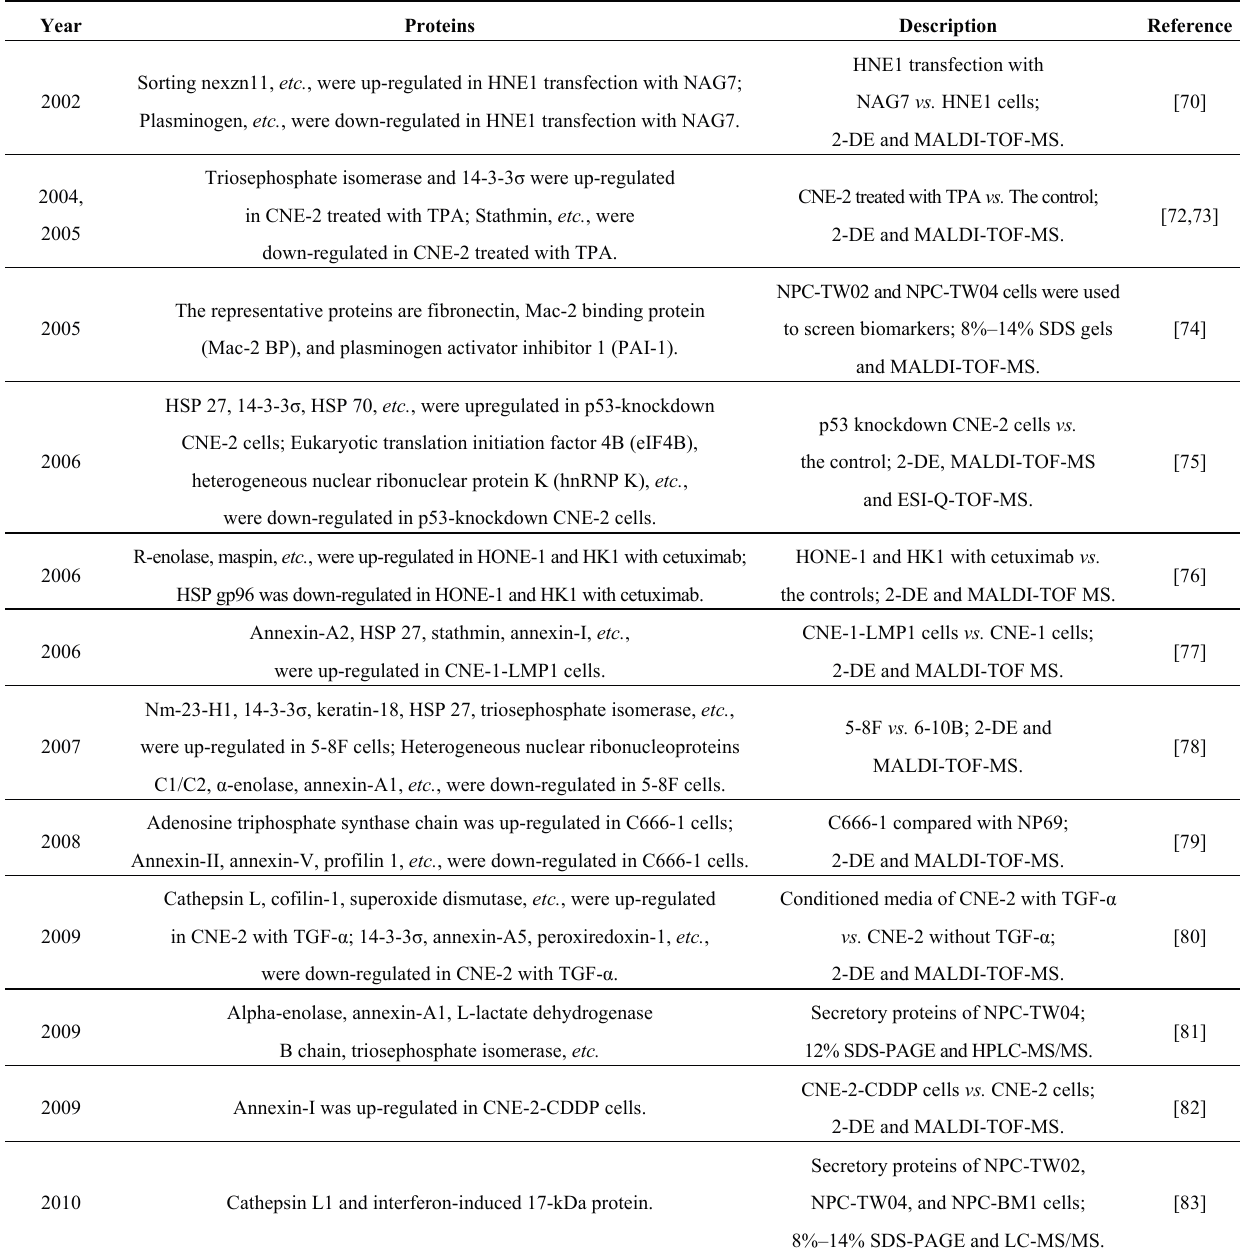
Table 1. The proteomics of cell lines related to nasopharyngeal